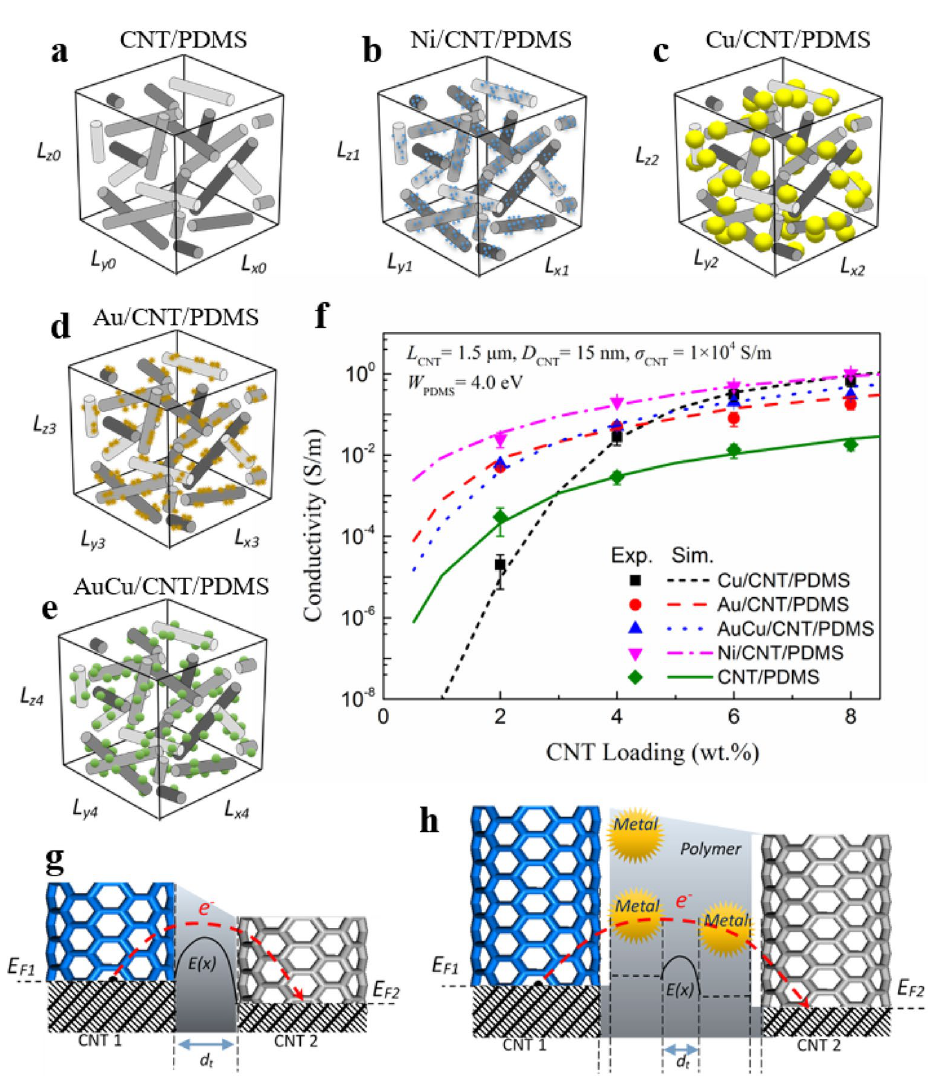
Figure 5. Schematic diagram of RVC on ( a ) CNT/PDMS, ( b ) Ni/CNT/PDMS, ( c ) Cu/CNT/PDMS, ( d ) Au/ CNT/PDMS, ( e ) AuCu/CNT/PDMS. Comparison of experiment and simulation data on Metal/CNT/PDMS films ( f ). Schematic diagram of ( g ) CNT junctions and ( h ) Metal/CNT